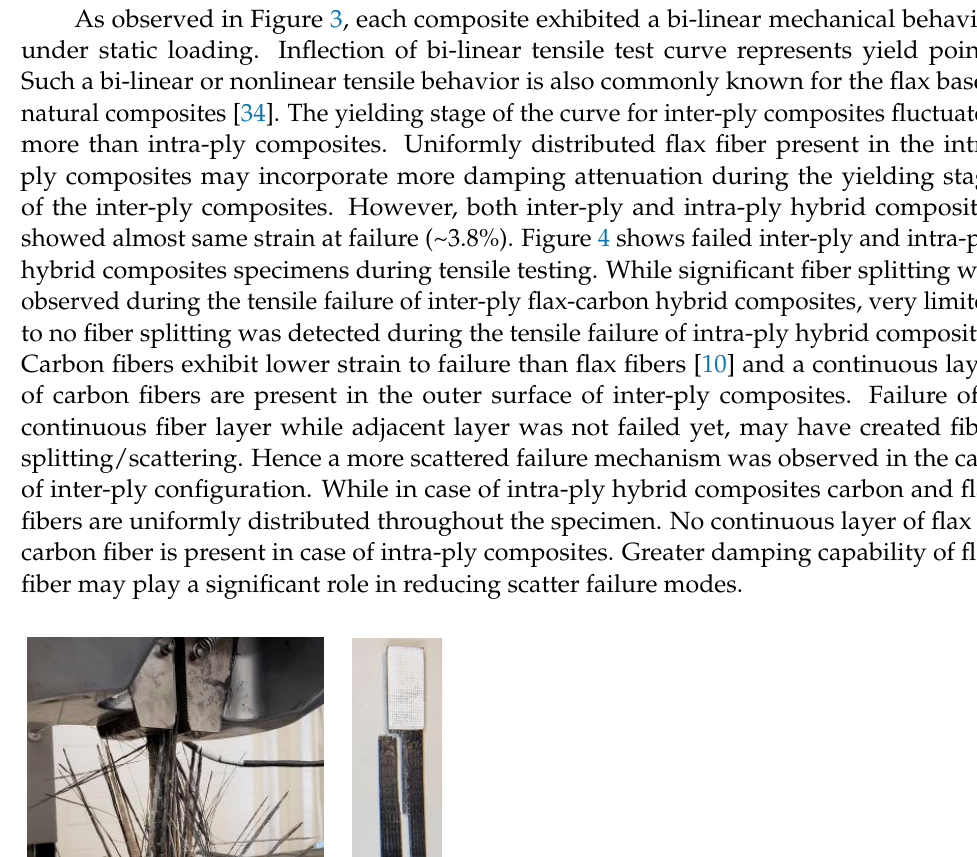
Figure 4. Failed specimen during tensile test ( a ) inter-ply ( b ) intra-ply flax-carbon hybrid composites.